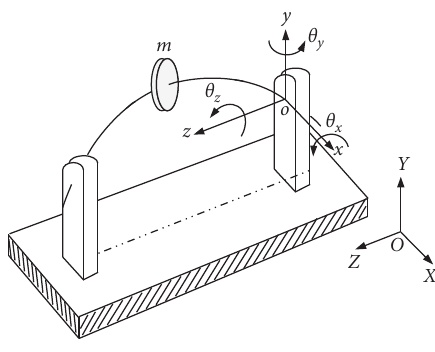
Figure 1: Coordinate system of